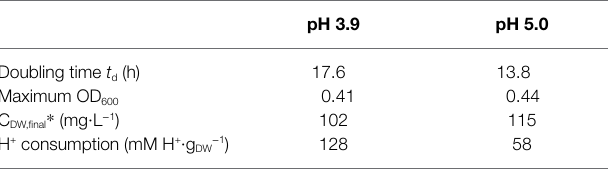
TABLE 3 | Summary parameters of bioreactor cultivation of Acididesulfobacillus acetoxydans gen. nov. sp. nov. strain INE at pH 3.9 and pH 5.0 when grown on 5 mM glycerol and 10 mM sulfate.